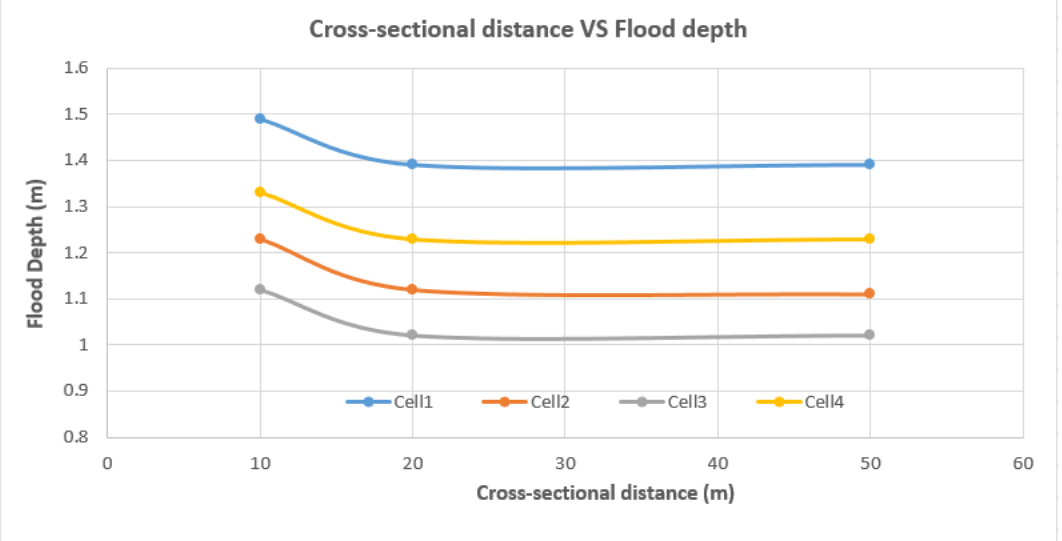
Figure 6. Change in the maximum flood depth value (Cells 1 – 4) for different cross-sectional distances in sub-reach K6.